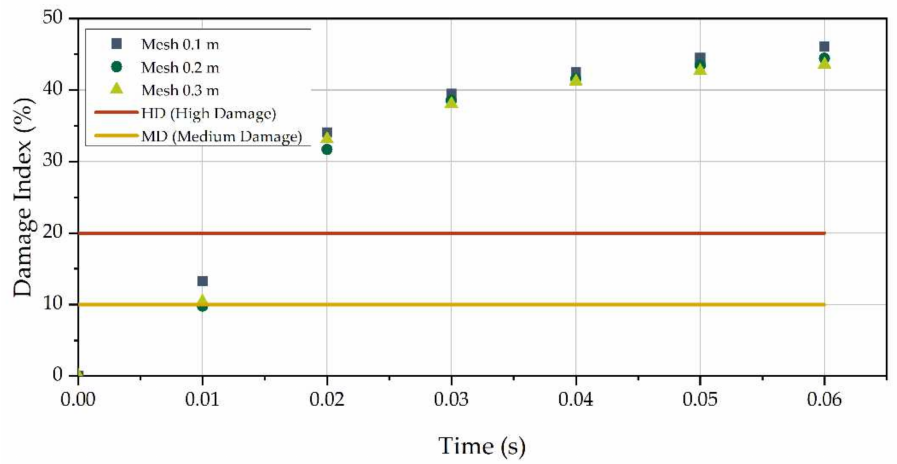
Figure 15. Damage index of the wall over